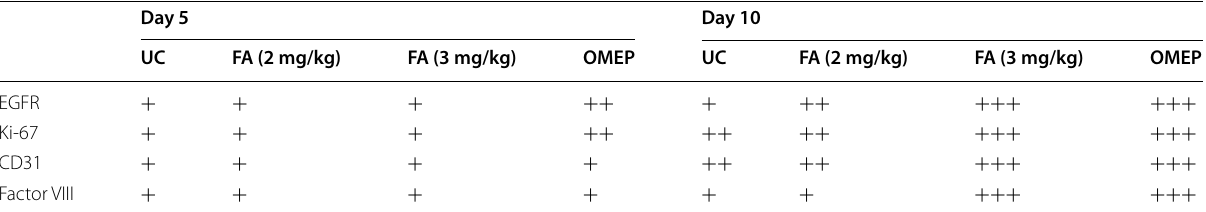
Table 5 Intensity of the immunoreactive EGFR, Ki-67, CD31 and Factor VIII positive cells in the ulcerated stomach treated with Folic acid (FA) and Omeprazole